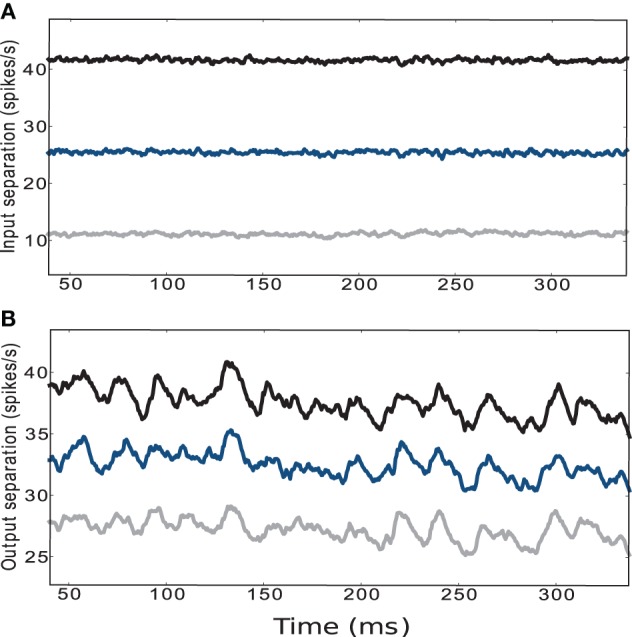
(A) Euclidean separation of the low-pass filtered cortical input activity. (B) Output activity of the striatal microcircuit with weight scaling factors configured as {ws = 18, wc = 113} (black star markers in Figure 2). Curves are averaged over 25 samples consisting of 5 different initial conditions and circuit instantiations, where each network configuration receives 5 different pairs of sets of input trains corresponding to the encoding of 5 randomly chosen pairs of positions. The distance between the pairs of positions is set to a hundredth (gray), a tenth (blue) and a fifth (black) of the environment's width.